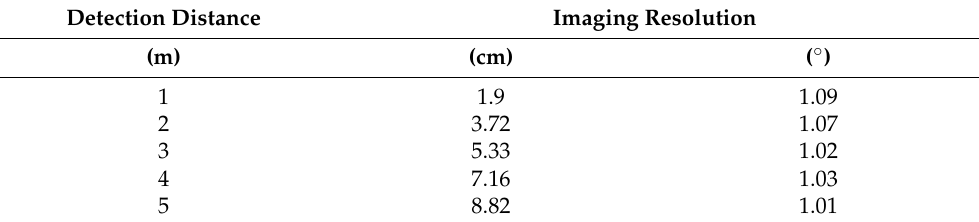
Table 2. Resolution measurement results of the system at different detection distances.